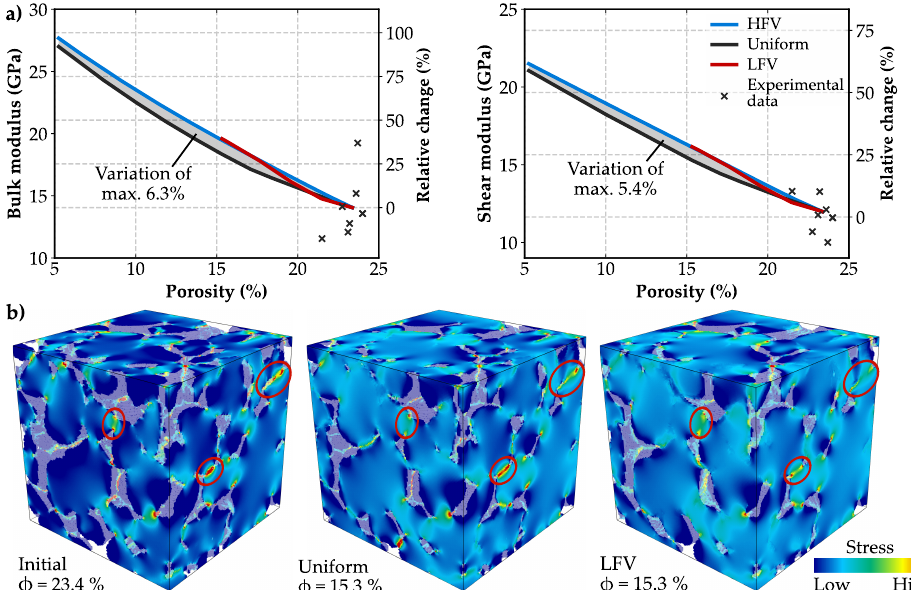
Figure 8. ( a ) Absolute and percentual increases in bulk and shear moduli due to preferential precipitation at high flow velocity magnitudes (HFV, red), low flow velocity magnitudes (LFV, blue) and uniform alterations, independent of the fluid flow (black). Calculated elastic properties are in good agreement with published laboratory data [68–72,78,79]. ( b ) Stress distribution within the initial microstructure compared to the uniform and LFV alteration patterns. Stress peaks are observed at the grain contacts (red